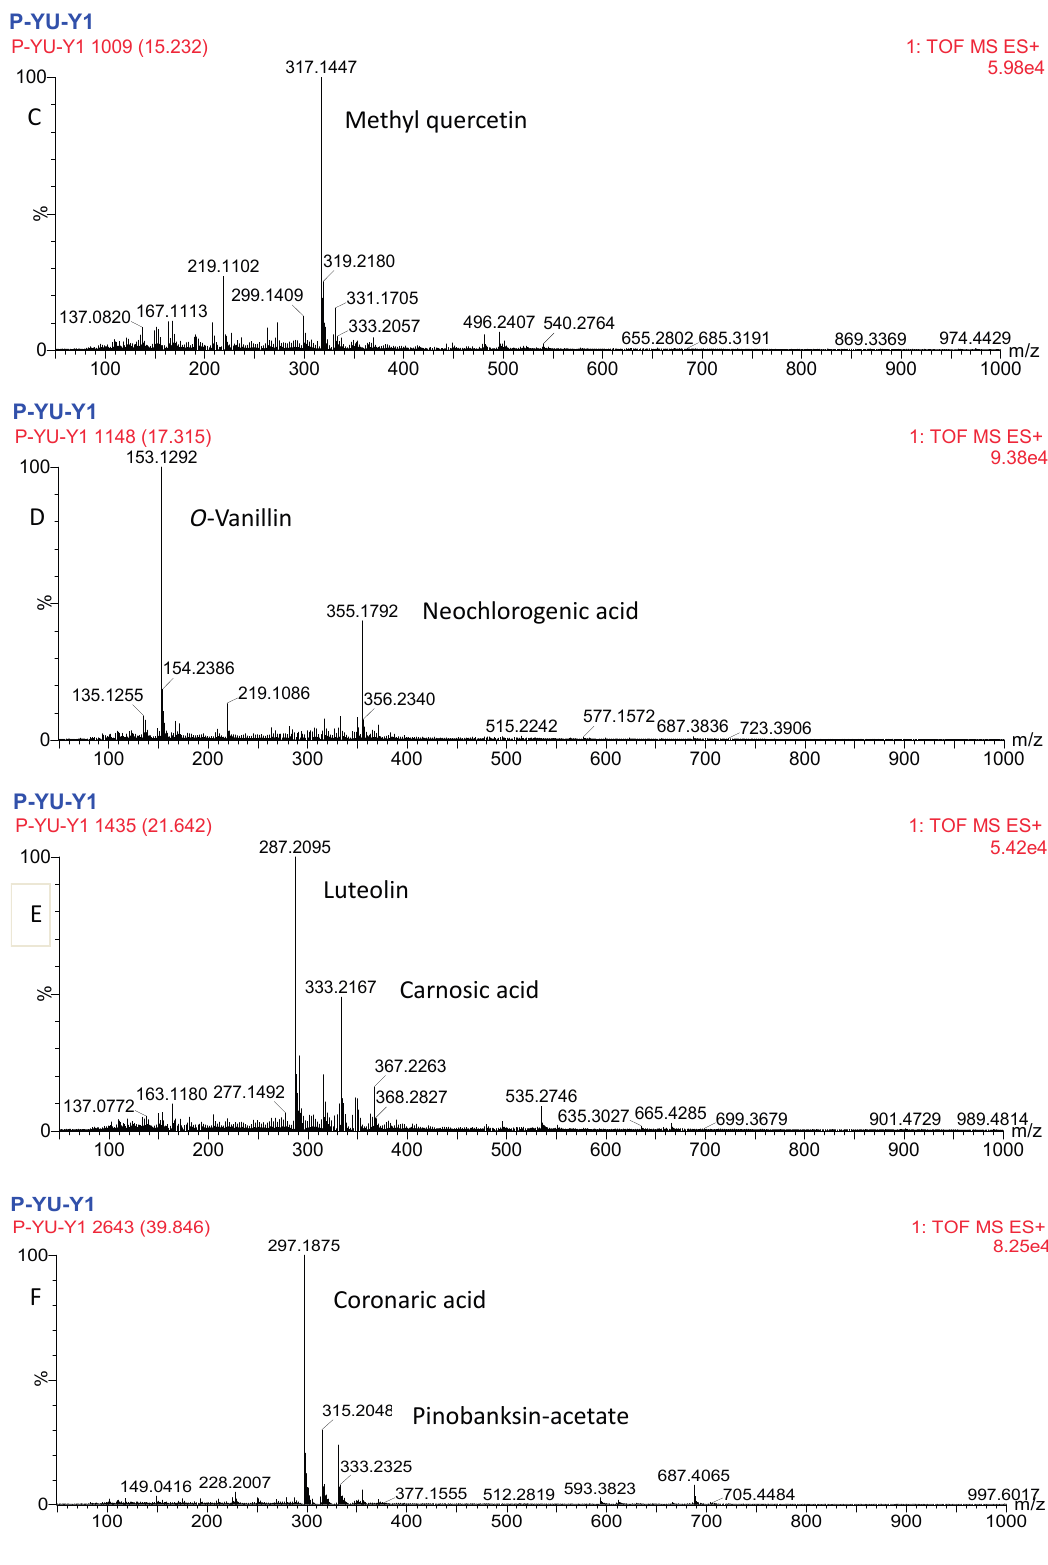
Figure 4. UPLC-Q-TOF-MS total ion chromatogram (TIC) of purified PPP and the ion chromatograms of representative peaks. ( A ) Total ion chromatographic profiling of purified PPP; ( B ) MS/MS spectrum of peak 1; ( C ) MS/MS spectrum of peak 8; ( D ) MS/MS spectrum of peak 9; ( E ) MS/MS spectrum of peak 13; ( F ) MS/MS spectrum of peak 22. Mass spectral data positive mode of